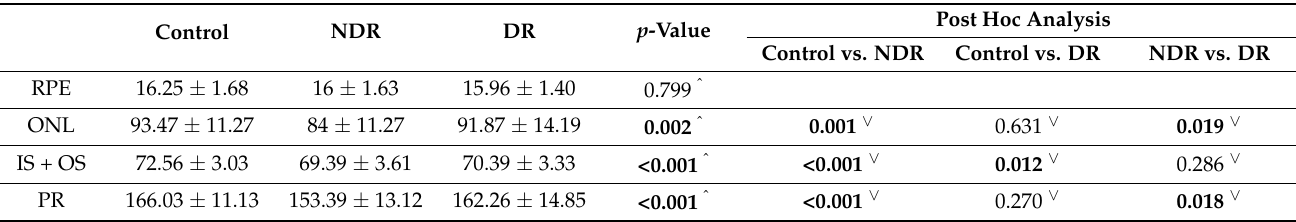
Table 7. Retinal layer thickness among study